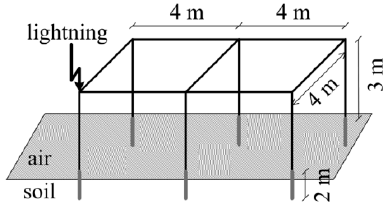
Figure 12. A Simple Grounding Grid.